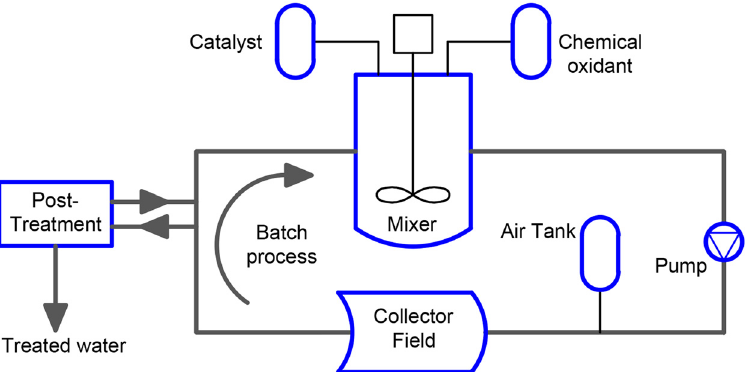
Figure 16: Solar - assisted wastewater treatment plant